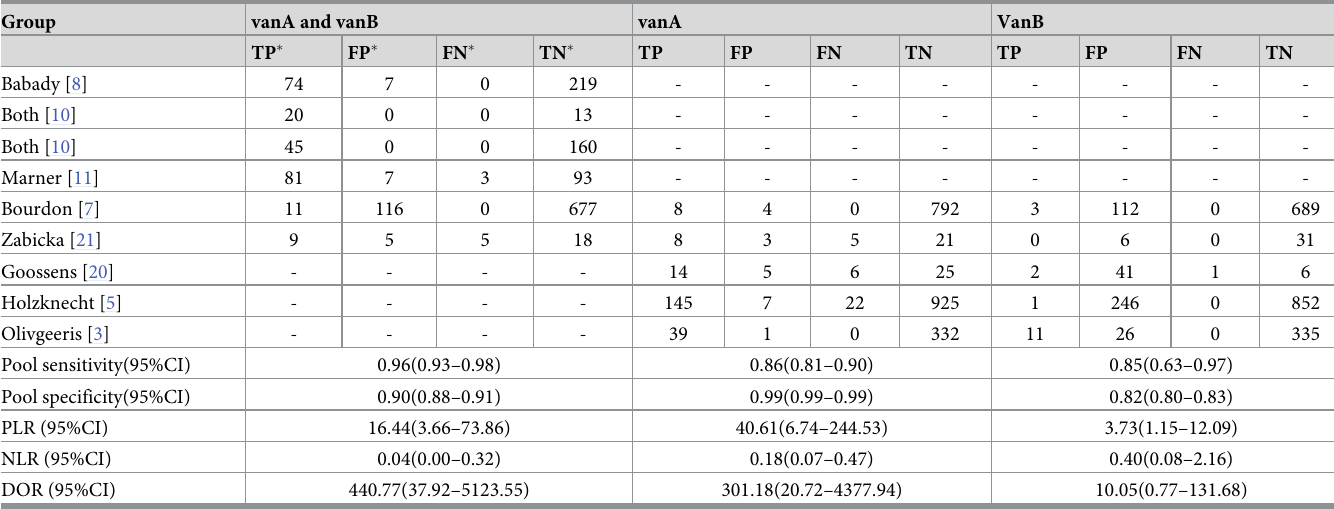
Table 3. Summarized results of the